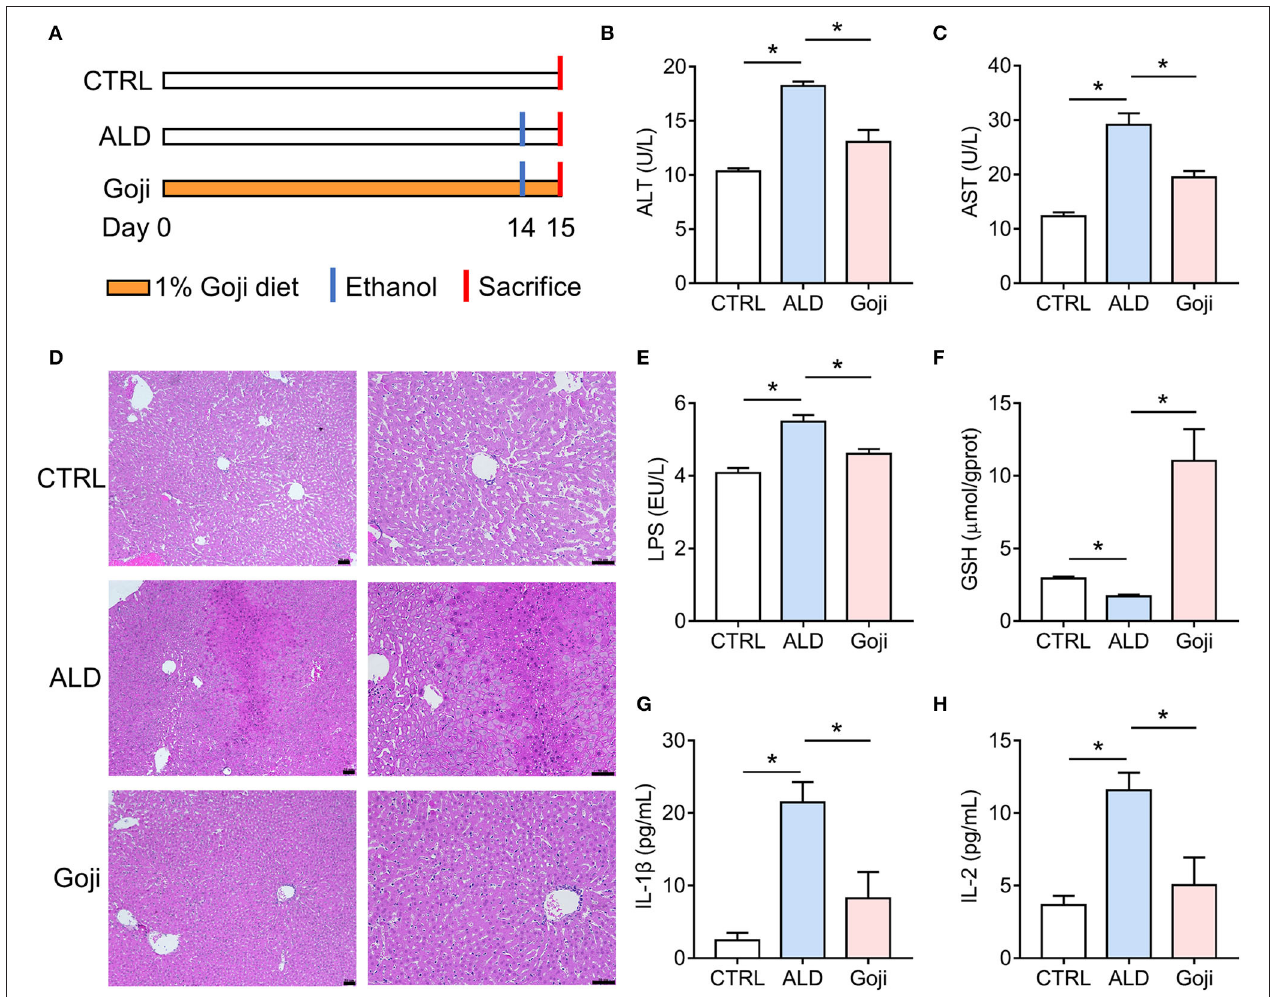
FIGURE 1 | Dietary Goji prevented acute alcohol-induced liver injury in mice. (A) Experiment design. (B) AST level in serum. (C) ALT level in serum. (D) the representative sections of liver stained with hematoxylin and eosin (100 × , 200 × ). Scale bars, 50 µ m. (E) The concentration of LPS in the liver. (F) the concentration of GSH in the liver. (G) the level of IL-1 β in serum. (H) the level of IL-2 in serum. n = 6–8 for B–F; n = 3–4 for G and H. Data are shown as mean ± SEM, and statistical significance is assessed by one-way ANOVA corrected for multiple comparison by Tukey’s test. * p -value <